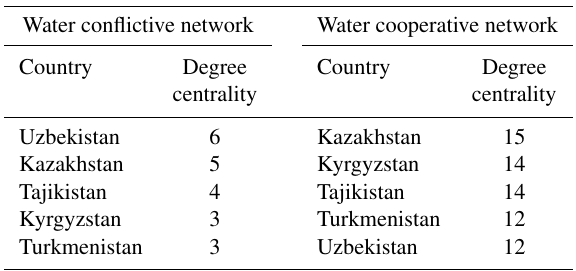
Table 4. Degree centrality of water conflictive and cooperative net- work for the five Central Asian countries after the collapse of the former Soviet Union